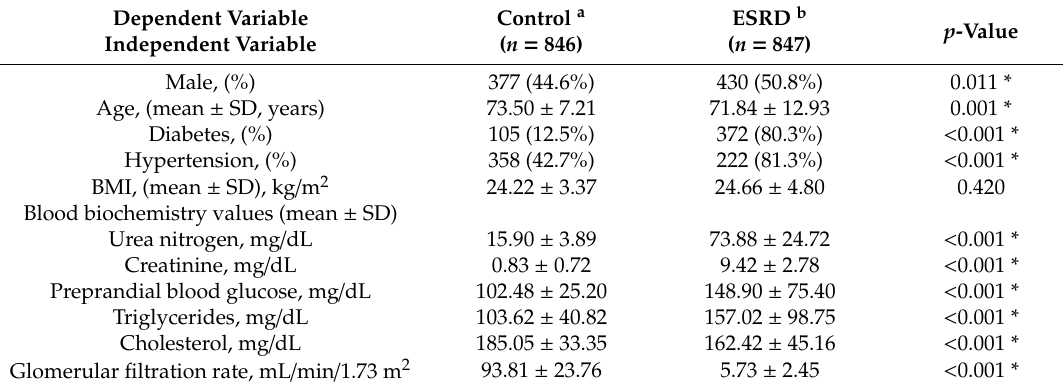
Table 2. Demographic and blood biochemical values distribution for ESRD patients.